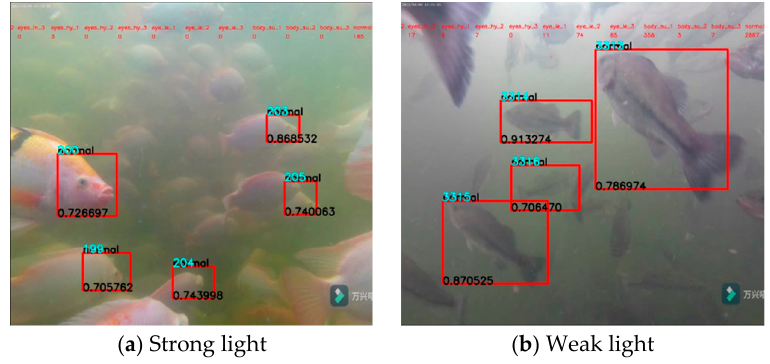
Figure 10. Monitoring effect at different light conditions.